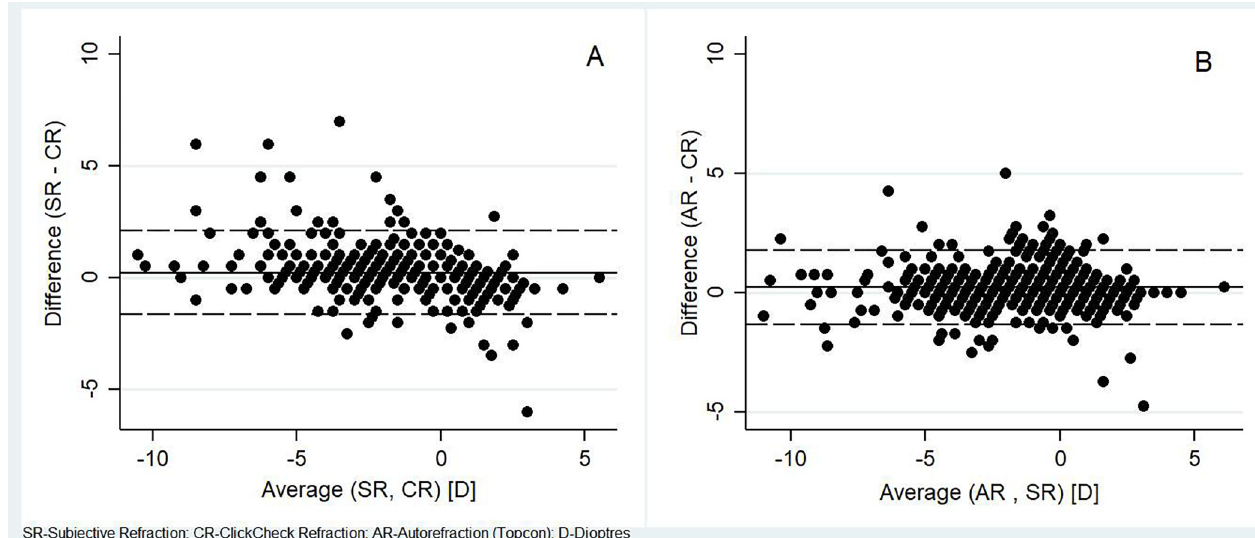
Fig 3. Bland Altman plot comparing the agreement of measurements by subjective refraction (SR), Conventional autorefraction (AR) and ClickCheck TM refraction (CR): A) Subjective refraction vs ClickCheck refraction, B) Auto refraction vs ClickCheck refraction.